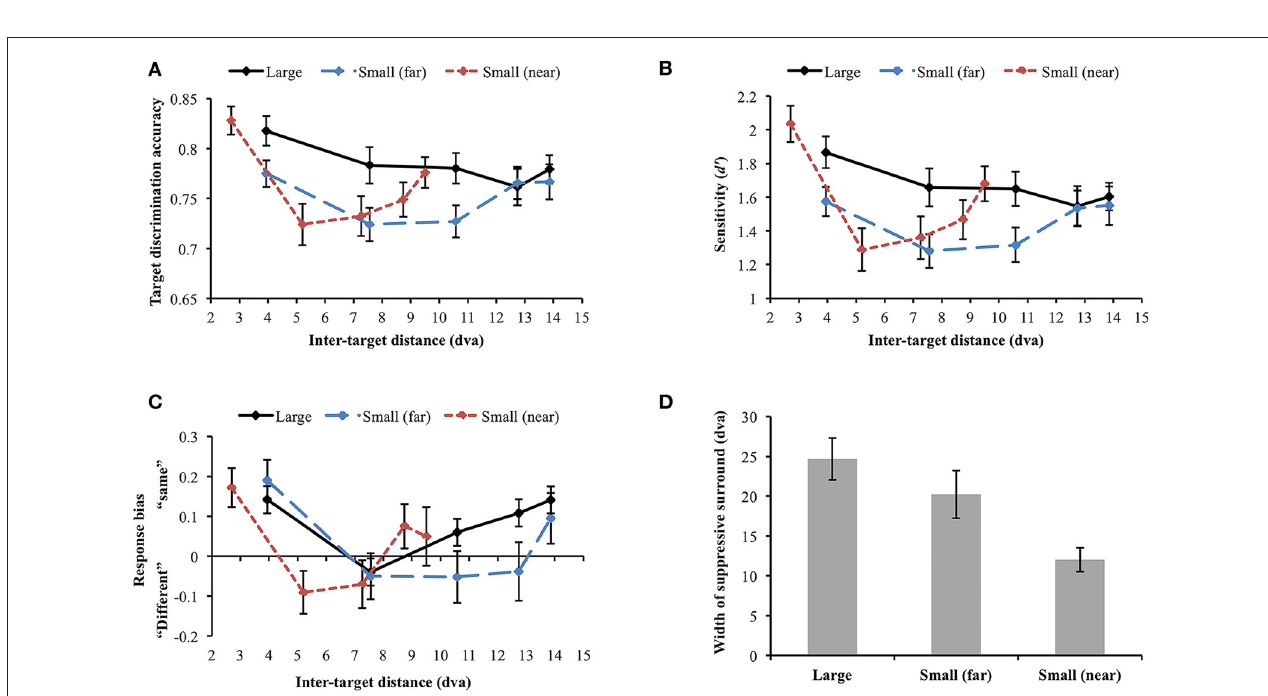
FIGURE 6 | (A) Orientation target discrimination accuracy (proportion correct) in different stimulus size and eccentricity conditions. (B) The similar results were found when participants’ sensitivity was analyzed. (C) Response bias varied along sensitivity, demonstrating an association between higher sensitivity and “same” response tendency. (D) Widths of the attentional suppressive surrounds. The sizes of the attentional suppressive surrounds in the large and small (far) orientation conditions did not statistically differ. Small (near) orientation condition produced a narrower suppressive surround compared to the other conditions. Error bars indicate SEM.